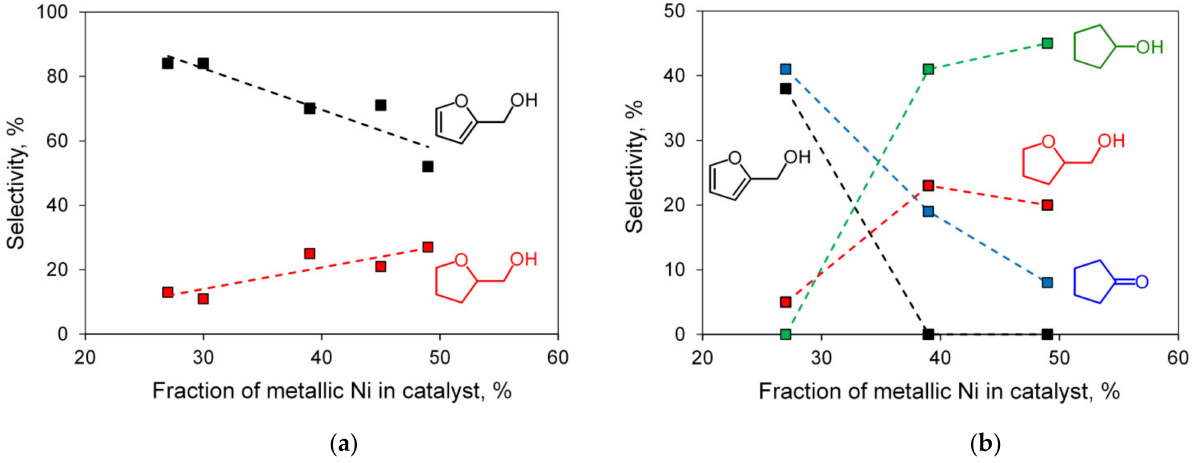
Figure 9. Selectivity to the hydrogenation products vs. fraction of metallic Ni in Ni@NiAlO x system (according to XRD data; see Table 2) for the FAL hydrogenation at 90 ◦ C, 2.0 MPa ( a ), and at 150 ◦ C, 3.0 MPa ( b